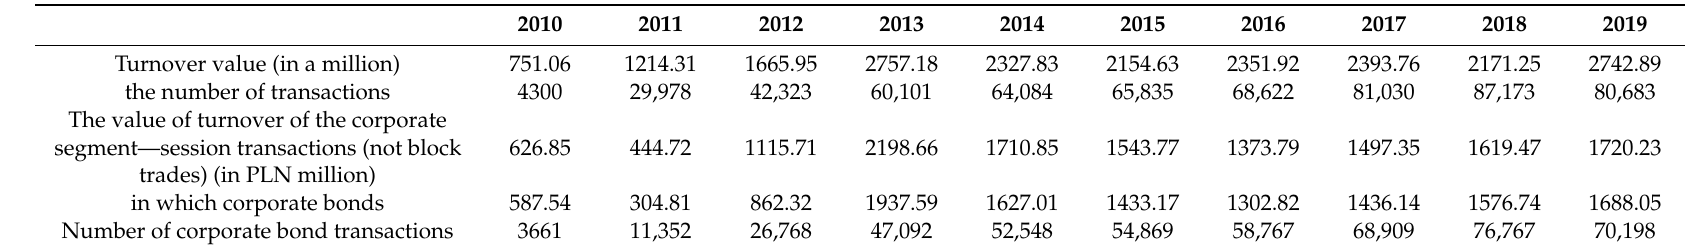
Table 3. Trading in financial instruments on the Catalyst market, detailing corporate